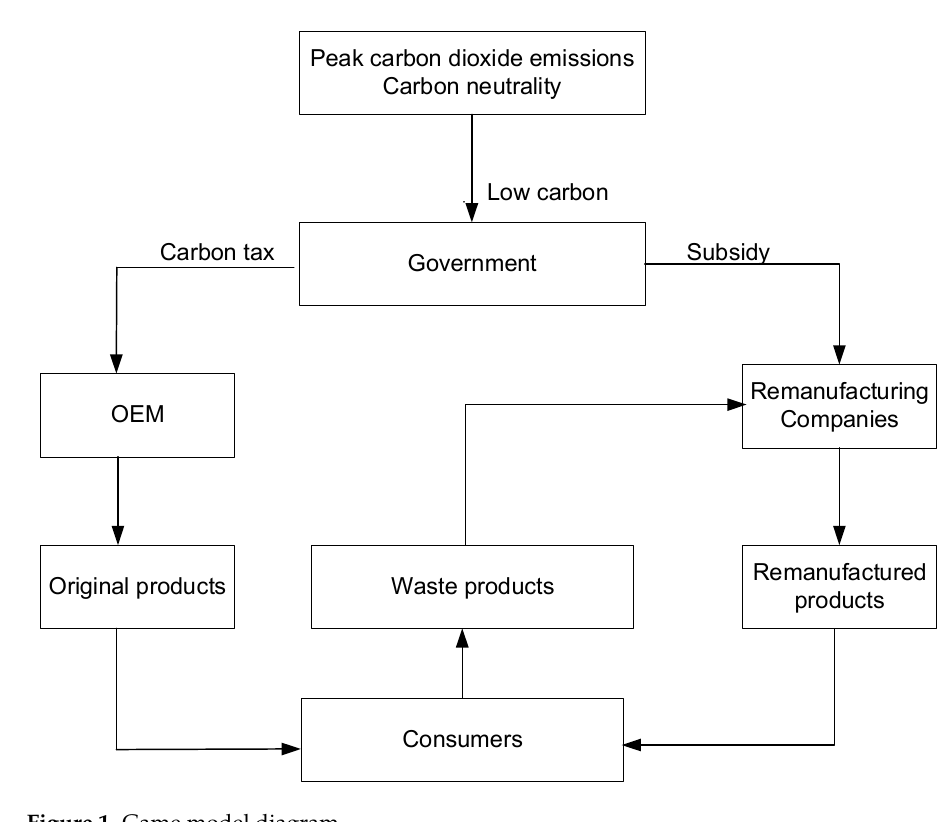
Figure 1. Game model diagram.